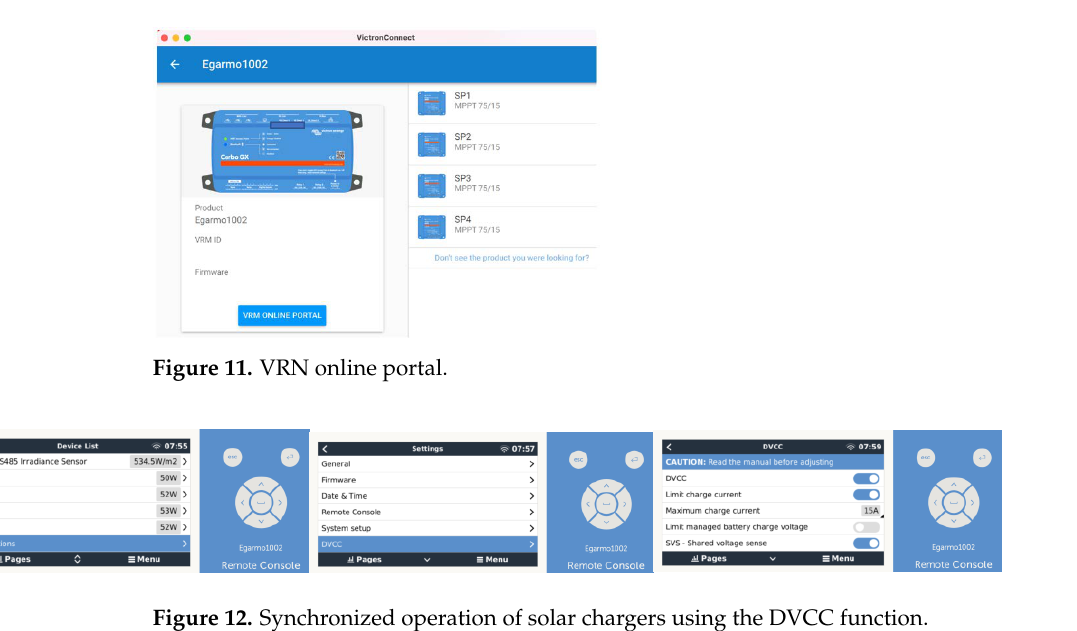
Figure 10. Victron connect app.